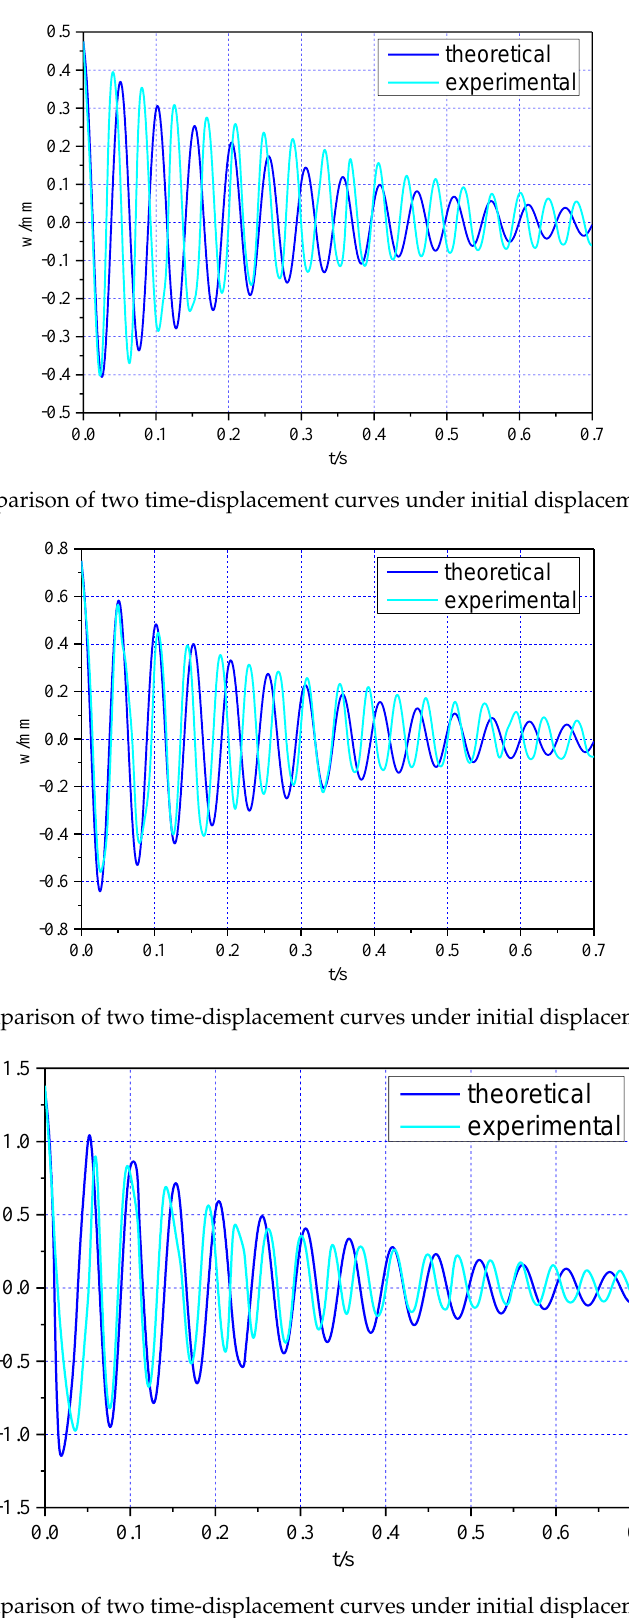
Figure 11. Comparison of two time-displacement curves under initial displacement 1.342 mm.